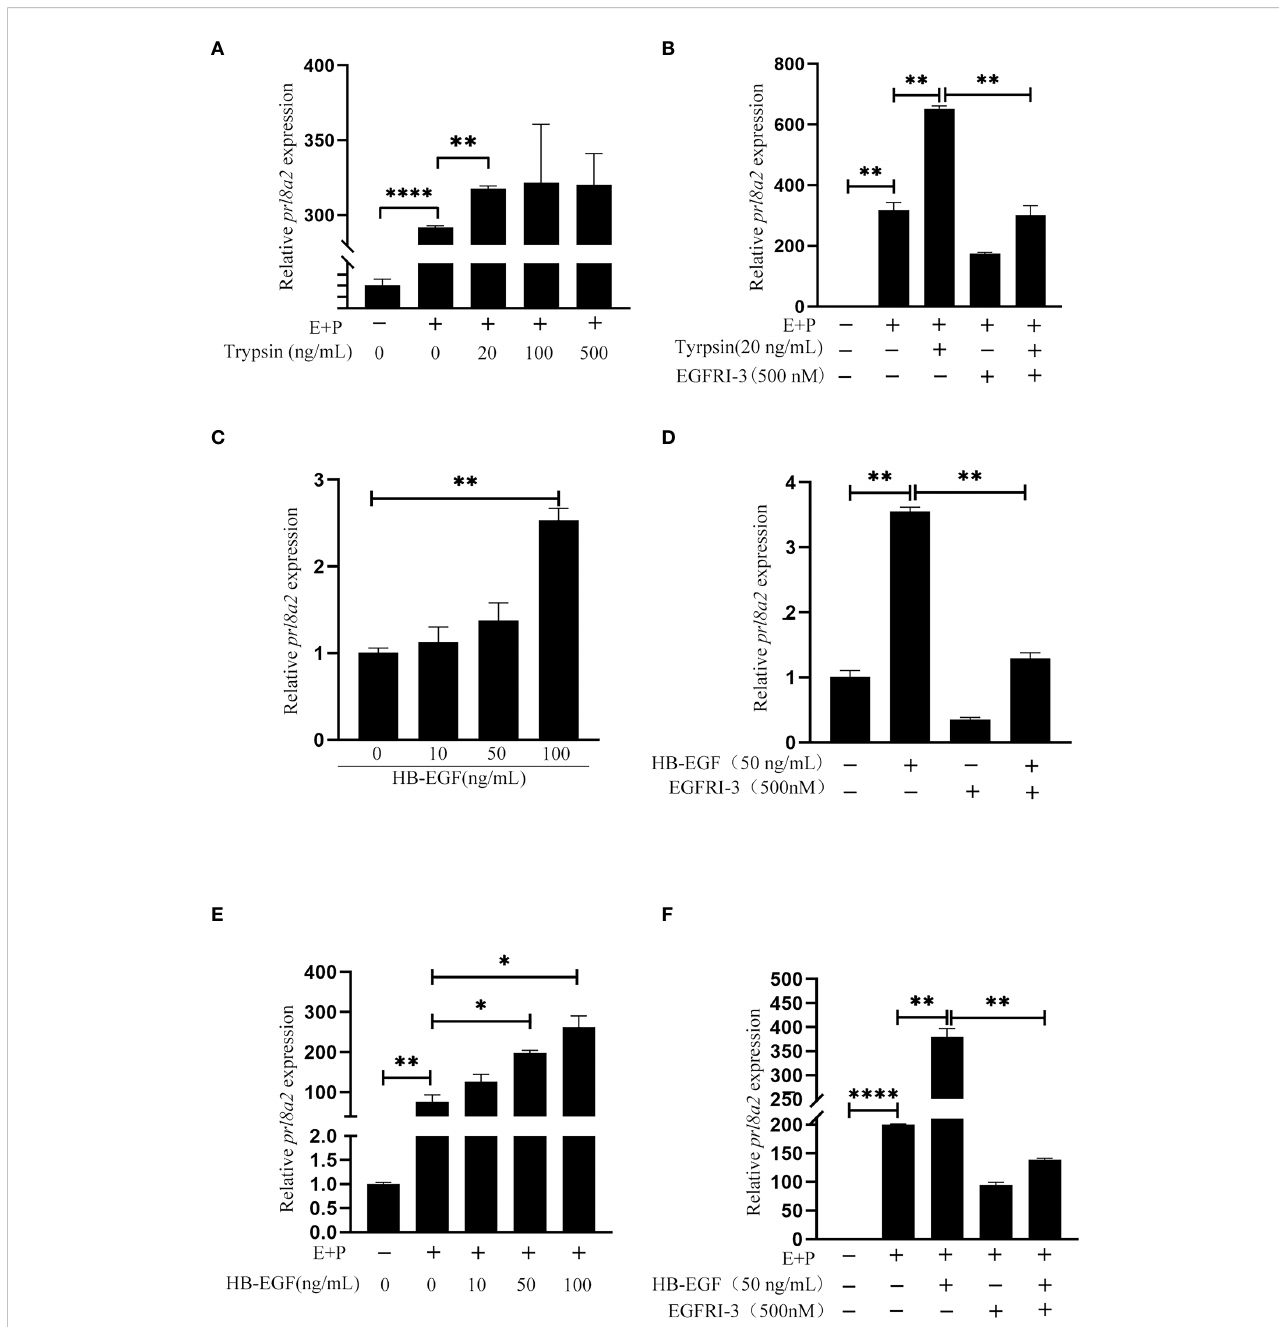
FIGURE 5 Effects of the conditioned medium from trypsin-treated epithelial cells and HB-EGF on mouse in vitro decidualization. (A) The Prl8a2 mRNA level after stromal cells were treated with the conditioned medium from trypsin-treated epithelial cells under in vitro decidualization. (B) Effects of EGFRI-3 (500 nM, EGFR inhibitor) on the Prl8a2 mRNA level after stromal cells were treated with the conditioned medium from trypsin-treated epithelial cells. (C) The Prl8a2 mRNA level after mouse stromal cells were treated with different concentrations of HB-EGF. (D) Effects of EGFRI-3 on Prl8a2 mRNA levels after stromal cells were treated with HB-EGF. (E) The Prl8a2 mRNA level after stromal cells were treated with HB-EGF under in vitro decidualization. (F) Effects of EGFRI-3 on Prl8a2 mRNA level after stromal cells were treated with HB-EGF under in vitro decidualization. The mRNA level of Prl8a2 was normalized to ribosomal protein 7 ( Rpl7 ) mRNA level. *p < 0.05, **p < 0.01, ****p <